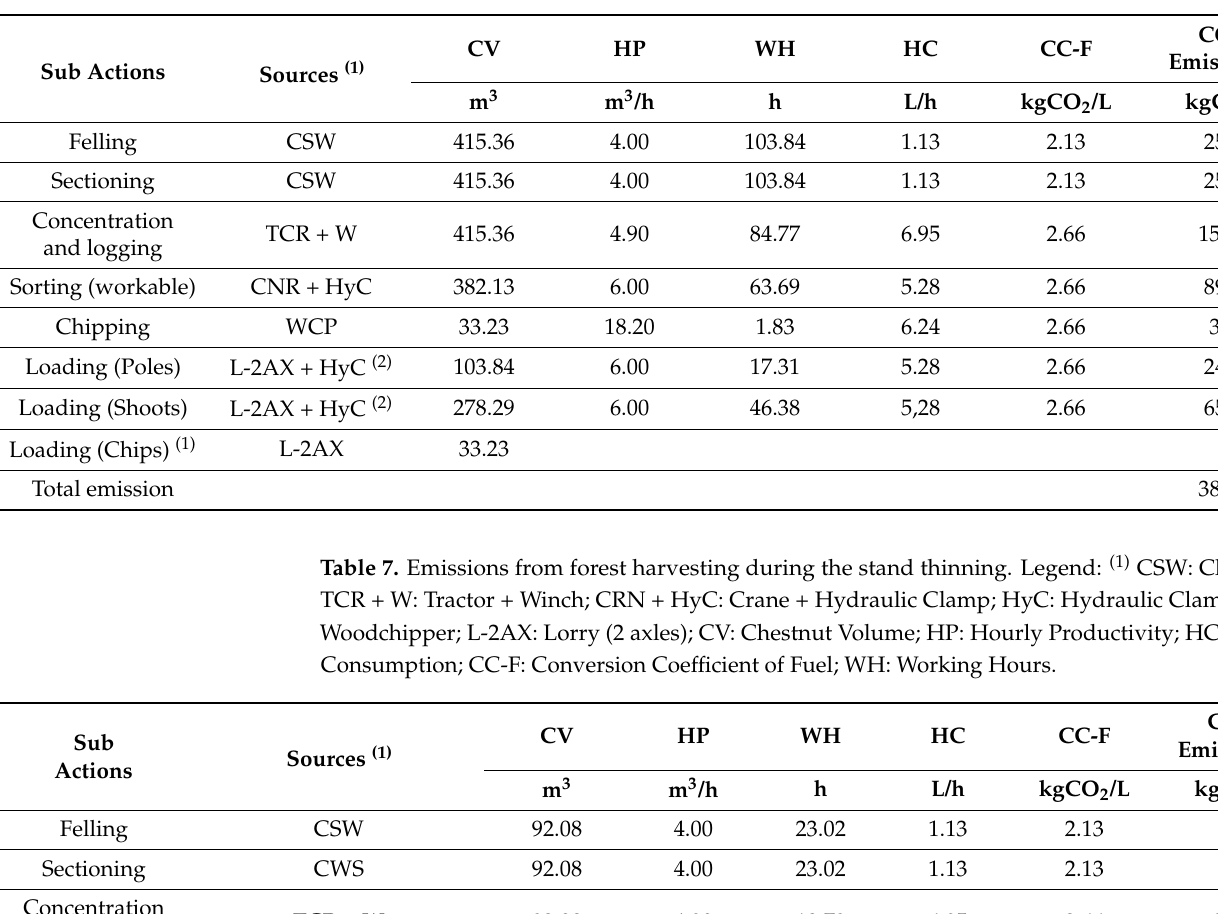
Table 6. Emissions from forest harvesting during the final cut. Legend: (1) CSW: Chainsaw; TCR + W: Tractor + Winch; CRN + HyC: Crane + Hydraulic Clamp; HyC: Hydraulic Clamp; WCP: Woodchipper; L-2AX: Lorry (2 axles); CV: Chestnut Volume; HP: Hourly Productivity; HC: Hourly Consumption;